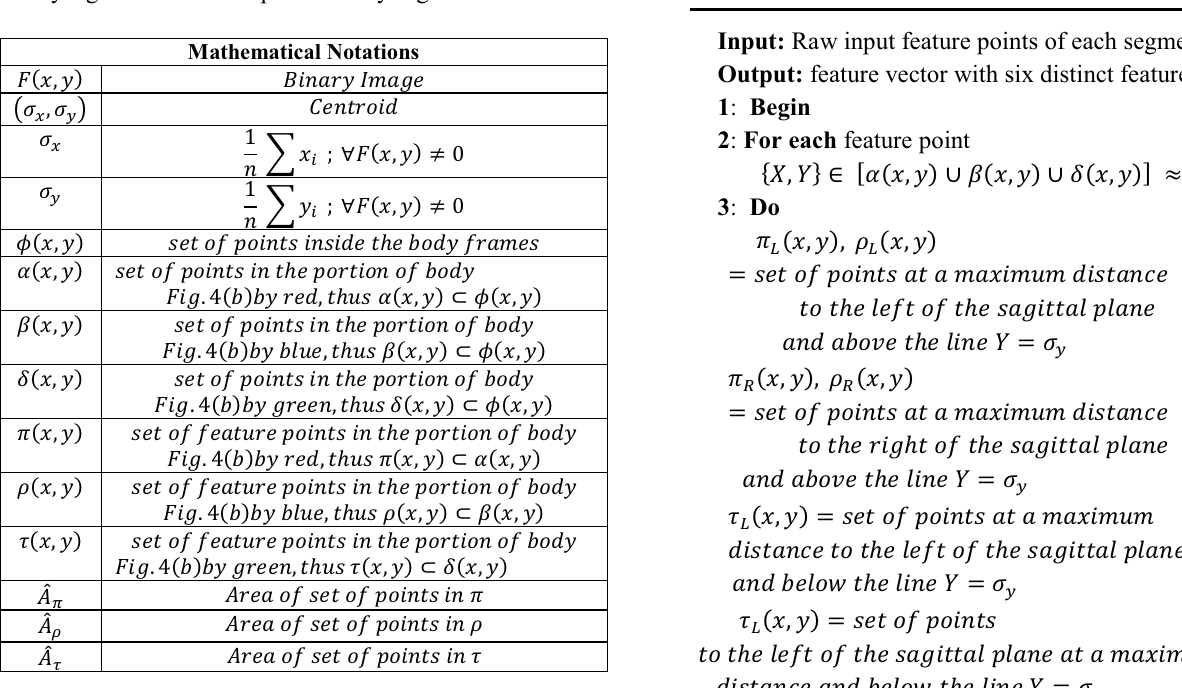
Fig.7. Illustration of feature points using polygon and convex hull shape for 10km/hr. gait speed The feature points for three different segments of human body (head, arm swing and leg swing) are shown in Fig. 6 and Fig. 7 for 2km/hr and 10km/ hr gait speed. These graphs illustrate the polygon and convex hull shape made by those feature points. The blue and green color indicate the polygon and convex hull shape respectively for left and right of the sagittal plane of human body. It has been observed that the shape of the convex hull for upper body and lower body segments is being shortened while changing the gait speed. Henceforth the relevant feature points are held responsible to extract intrinsic body signatures from respective body segments. Algorithm 1: Feature Extraction